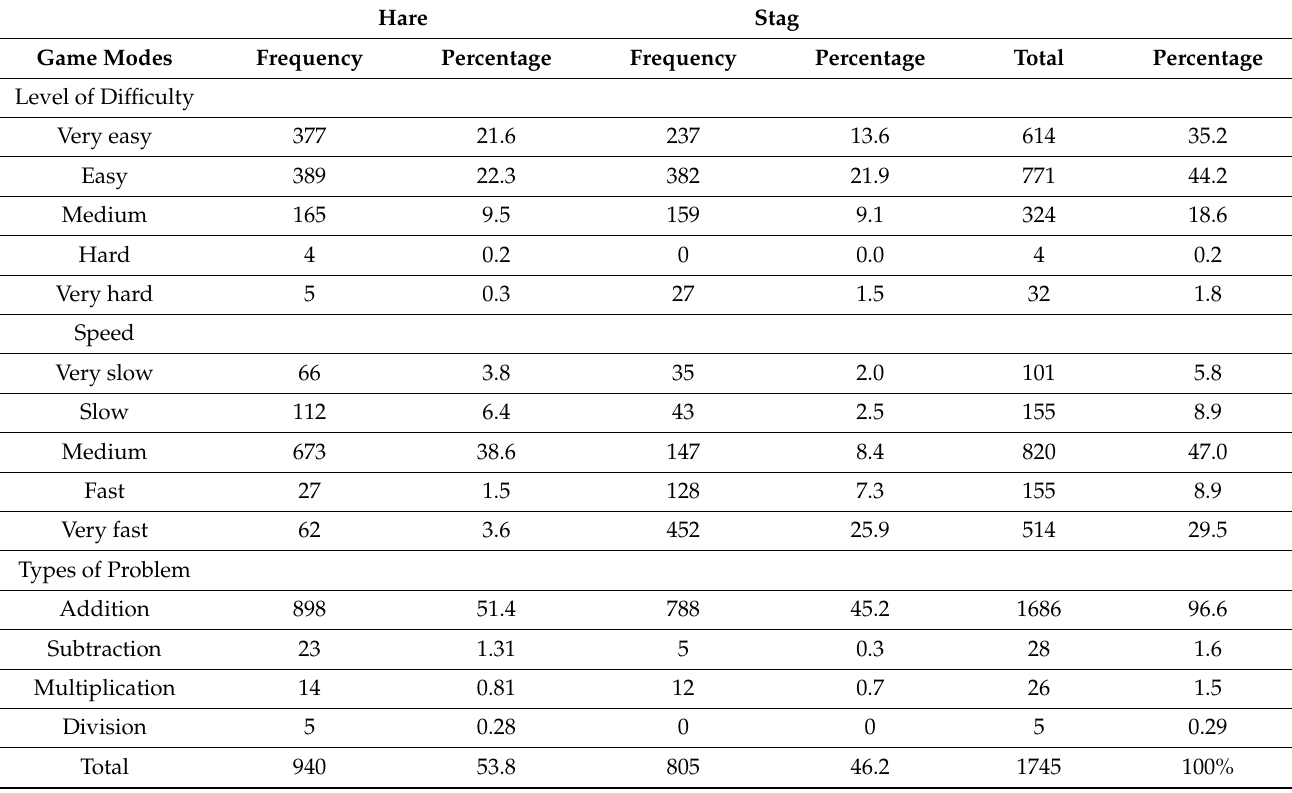
Table 3. The selected game modes of the students in the Ibigkas! Math in terms of level of difficulty, and types of arithmetic problems solved. Hare